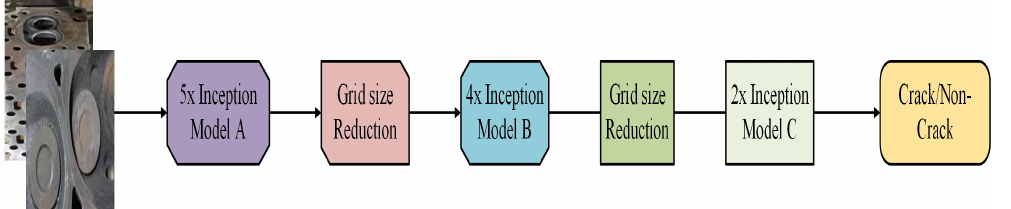
Figure 4. Framework of the InceptionV3 architecture.